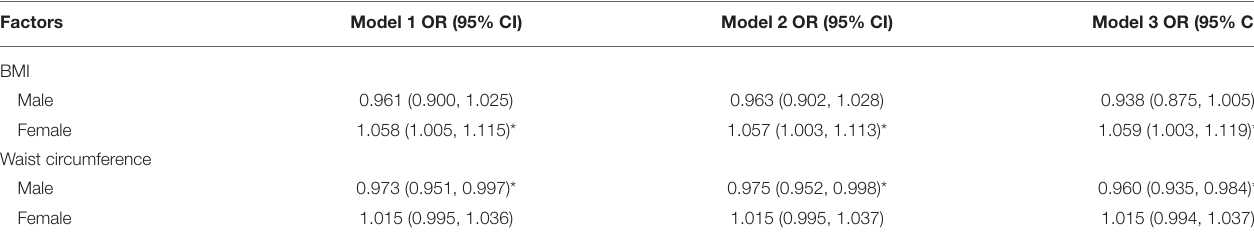
TABLE 4 | Association of BMI and waist circumference with cognitive impairment by sex, according to demographic characteristics and risk factor groups in the multivariate analysis. Factors Model 1 OR (95% CI) Model 2 OR (95% CI) Model 3 OR (95% CI)